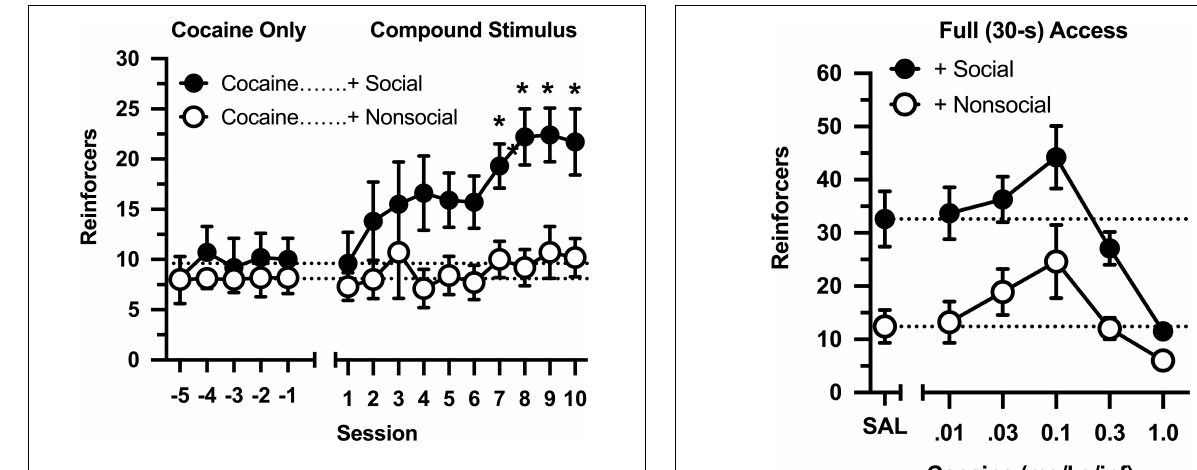
( Figure 2 ), with ascending and descending limbs converging at 0.1 mg/kg [main effect of dose: F (4,76) = 15.851, p <